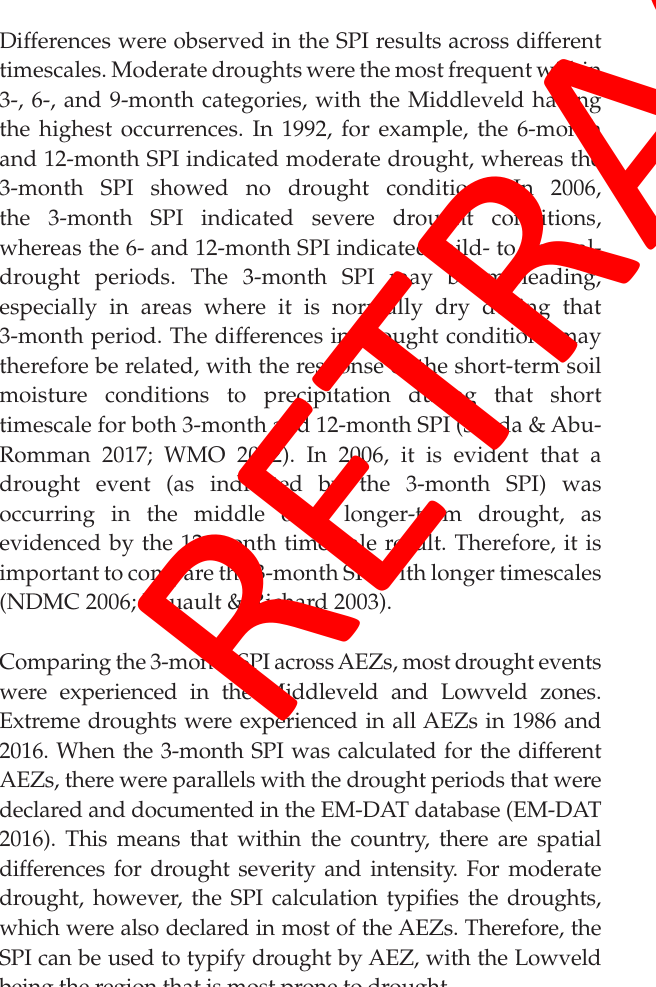
FIGURE 5: Three-month Standard Precipitation Index values for the Highveld, Middleveld, Lowveld and Lubombo Plateau agro-ecological